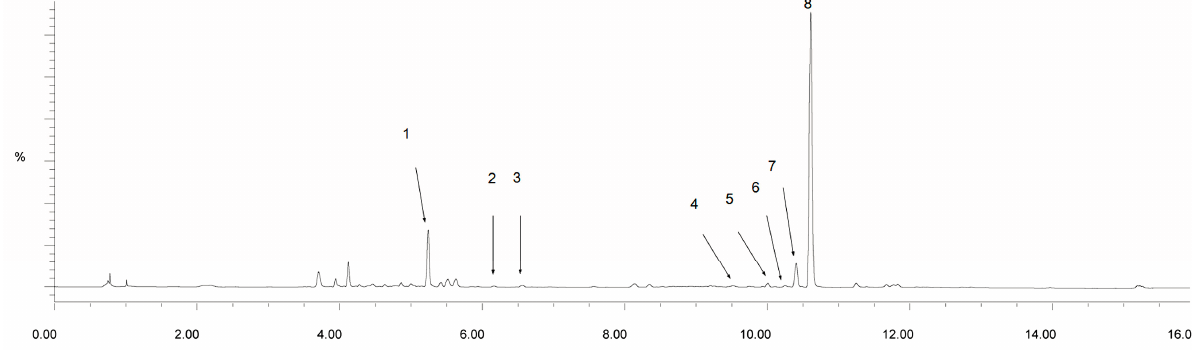
Figure 3. The total ion chromatogram of UPLC/Q-TOF-MS of Angelica sinensis. Peaks: (1) Ferulic acid; (2) Senkyunolide H/I; (3) Senkyunolide I /H; (4) Coniferyl ferulate; (5) Senkyunolide A; (6) n -Butylphthalide; (7) Ligustilide; (8)